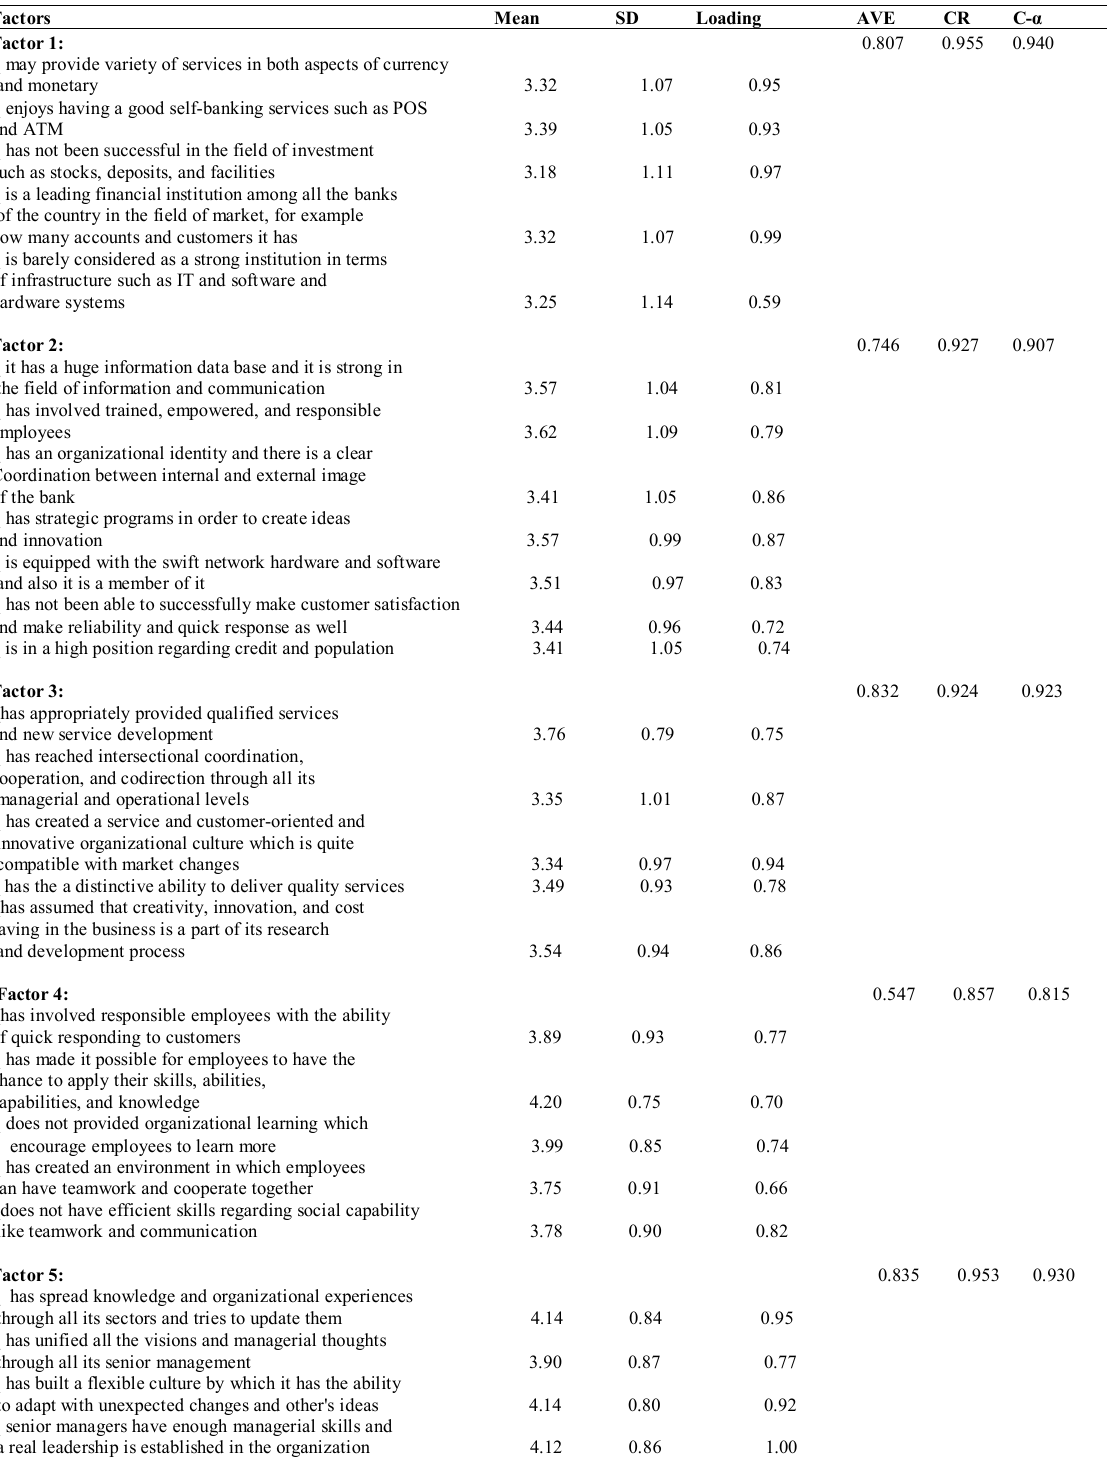
Results of CFA and internal reliability testing & K–M–O measure for